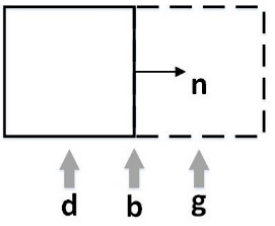
Figure 25. Cell stencil at the boundary.